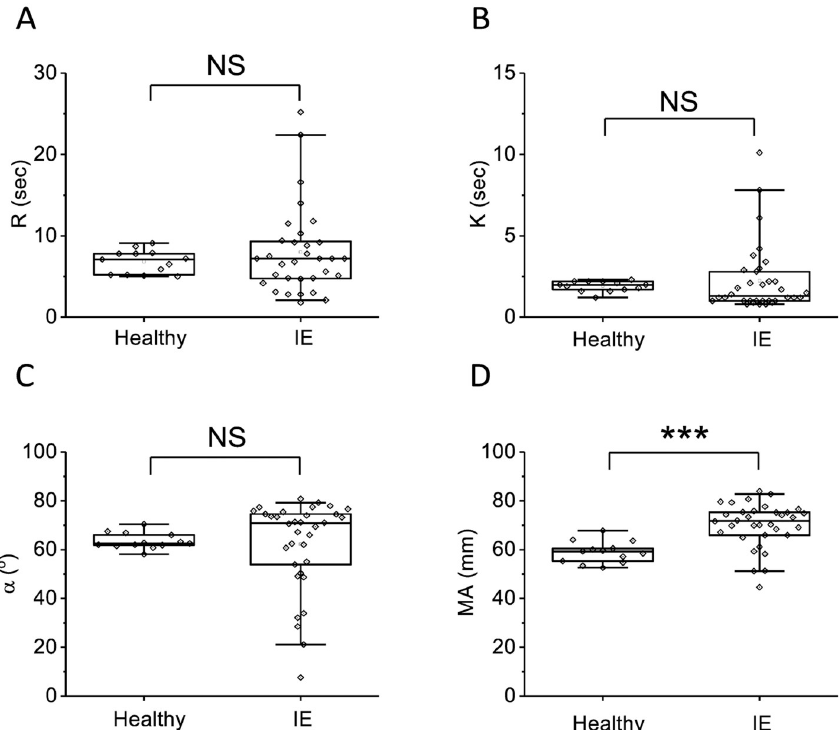
Fig 3. Parameters of the TEG in IE patients and healthy volunteers at admission. A—R (sec), B—K (sec), C— α (˚), D—MA (mm). The box plots indicate the following parameters: the mean value (the dot inside the box), the median (the horizontal line inside the box), the 25 th and 75 th percentiles (the bottom and top of the box, respectively) and 5 th and 95 th percentiles (the ends of the whiskers). Groups were compared according to Mann-Whitney test; � p < 0.05, �� p < 0.01, ��� p < 0.001, NS—not